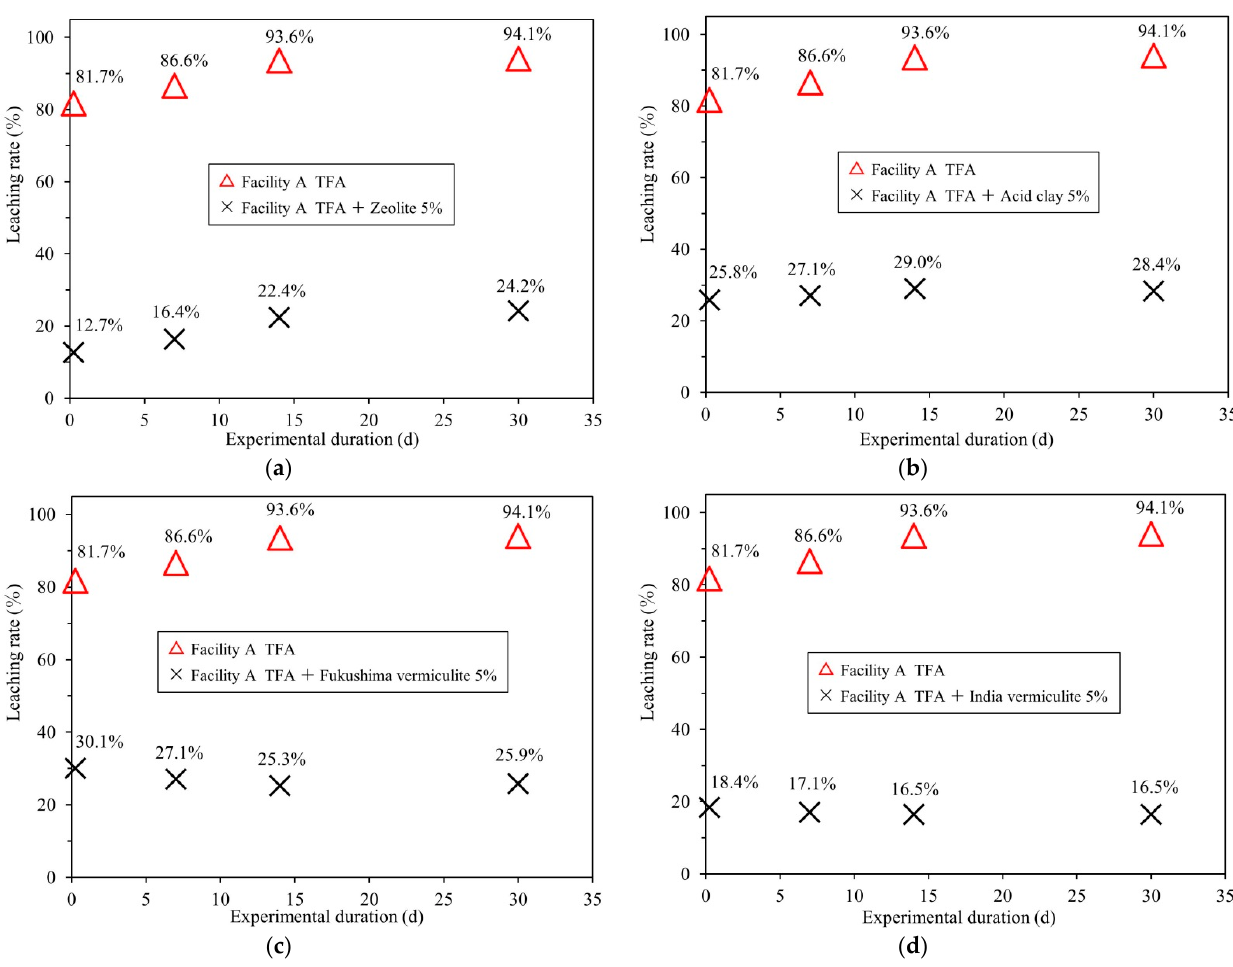
Figure 7. Changes in radioactive cesium leaching rate with respect to time (chelate-treated fly ash, TFA): ( a ) Zeolite; ( b ) Acid clay; ( c ) Fukushima vermiculite; ( d ) India vermiculite.